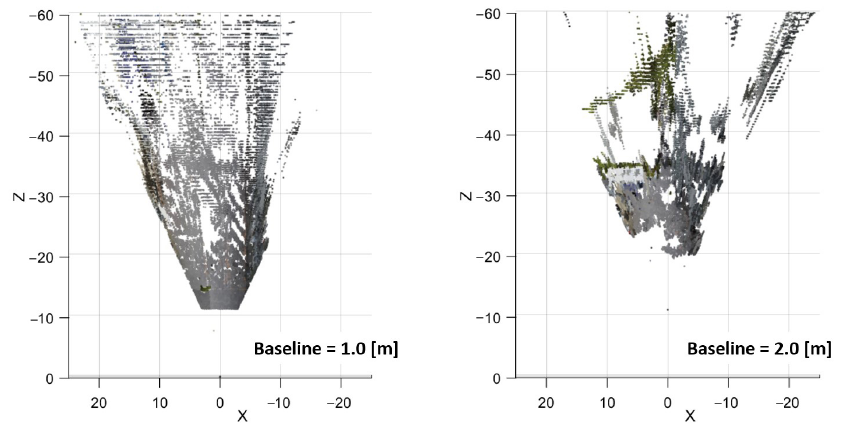
Figure 20. Point cloud generated from 1 and 2 m baseline seen from top–down